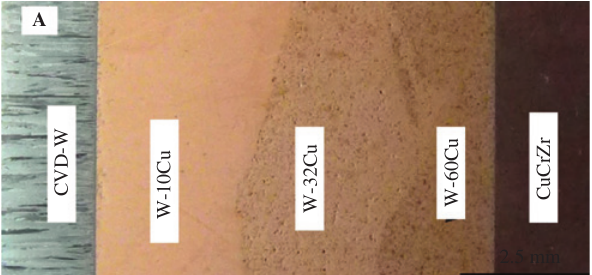
Figure 25: Micrograph of the cross section of W/Cu FGM prepared by CVD